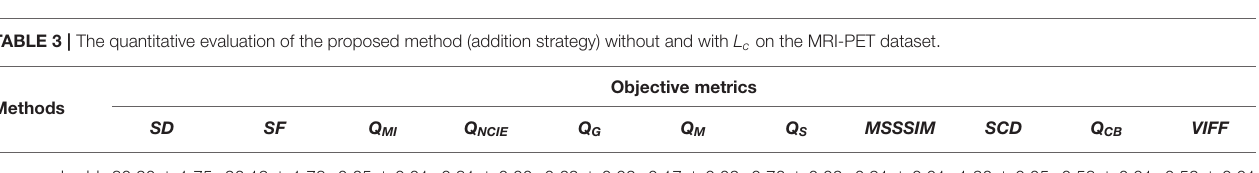
variance of 10-fold verification experiments. ±